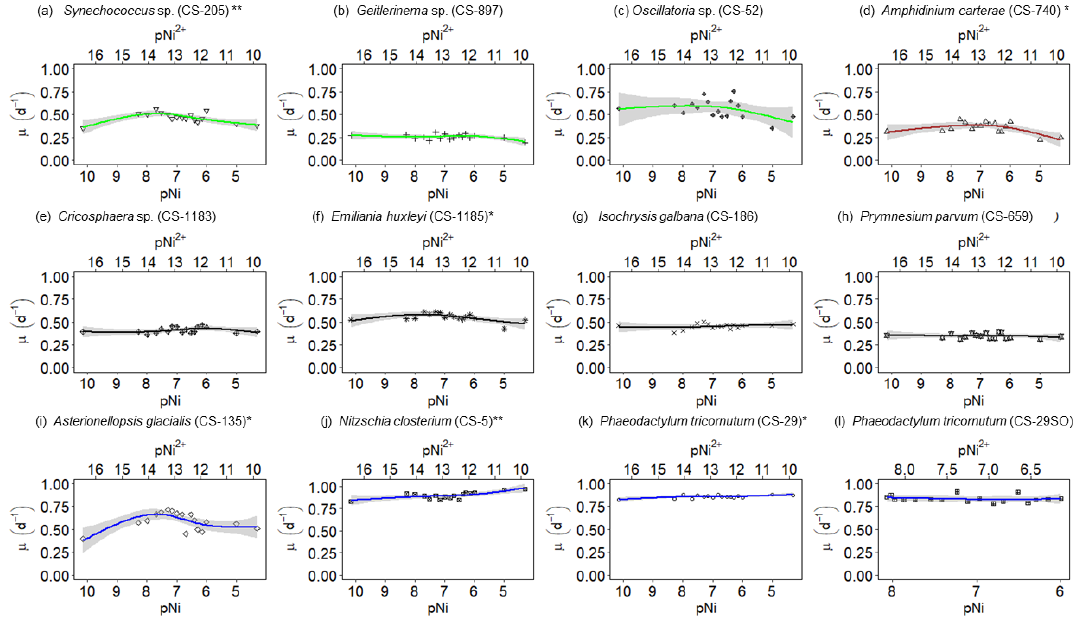
Figure 2. Growth rates of different phytoplankton strains in a large gradient of Ni concentrations. The species name is shown in each subplot with the strain number in the parentheses. p Ni and p Ni 2 + are the − log 10 transformed values of the total dissolved and free Ni concentrations, respectively (Eq. 1). A smaller value represents a higher concentration. Plots (a) – (c) are cyanobacteria; plot (d) is a dinoflagellate; plots (e) – (h) are haptophytes; plots (i) – (l) are diatoms. Plots (a) – (k) show growth rates in Aquil media, while plot (l) shows growth rates of P. tricornutum in natural seawater media. Solid lines represent the smooth terms produced from GAMs using the growth rate data and p Ni concentrations. Shading indicates the 95% confidence interval. P values < 0.05 indicate that the smooth term is significantly different from a straight horizontal line. P values < 0.05 are indicated by ∗ , and P values < 0.01 are indicated by ∗∗ after the species